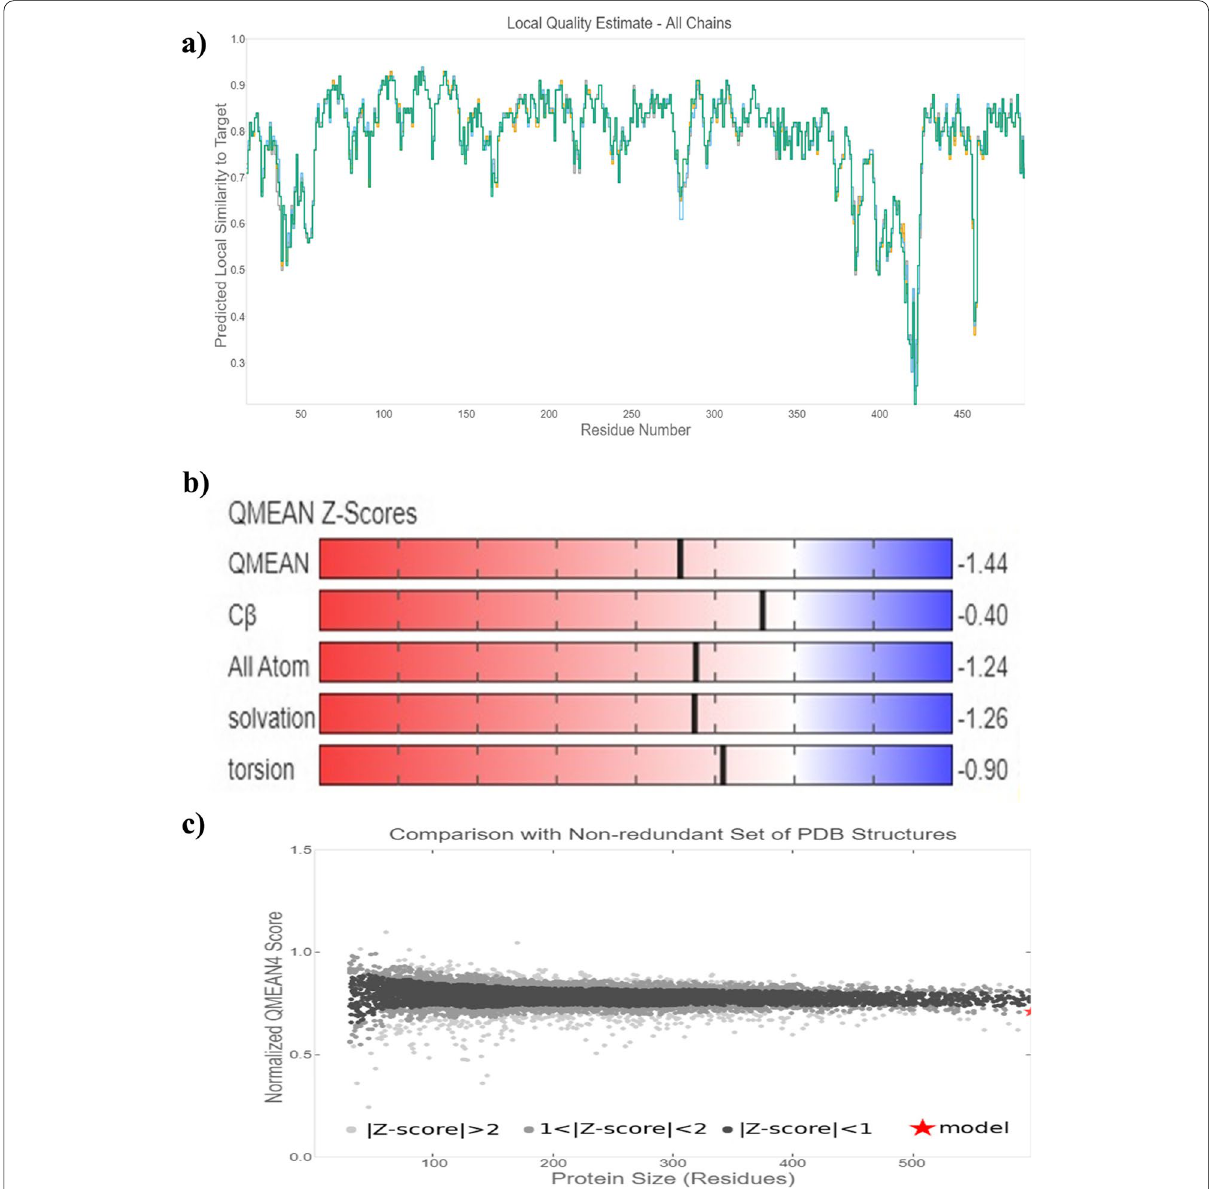
Fig. 4 Predicted protein model quality estimation by